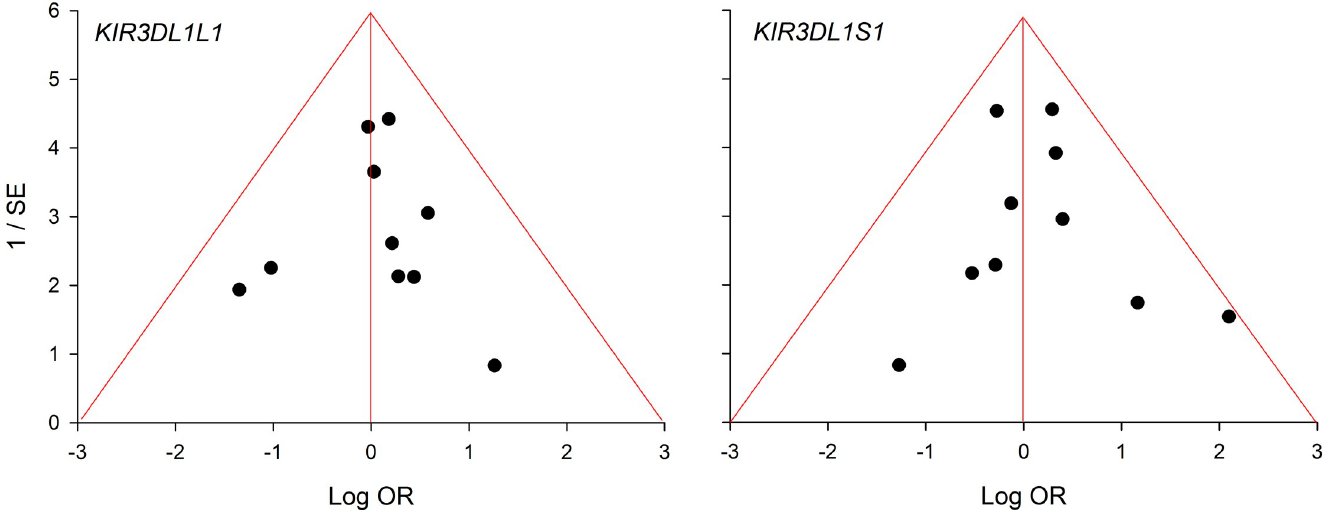
Fig 5. Funnel plot analysis of 3DL1/S1 genotype for publication bias. OR: odds ratio; SE: standard error.